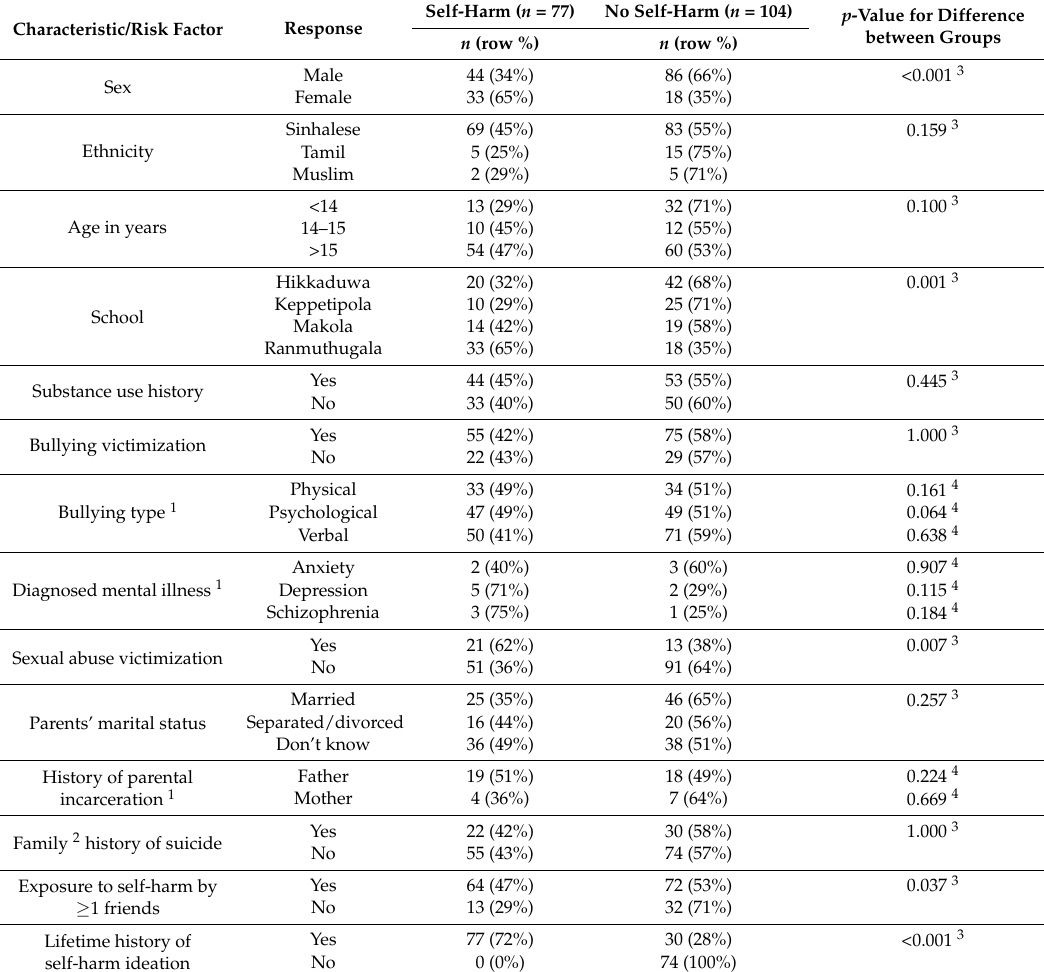
Table 1. Sample characteristics according to self-harm history in 181 justice-involved young people detained in certified schools in Sri